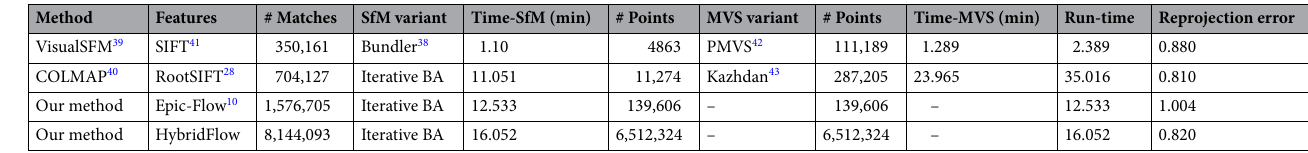
Table 2. The comparison of number of points reconstructed and reprojection error.